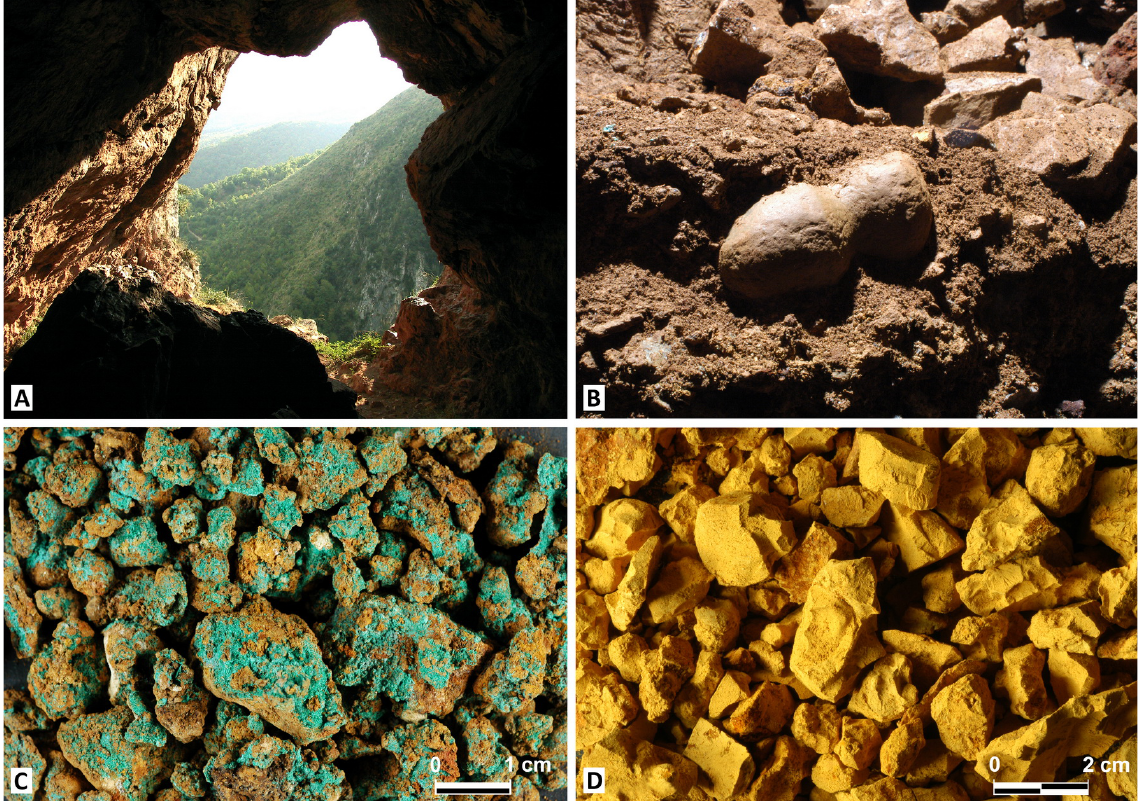
Figure 5. Grotta della Monaca (Sant'Agata di Esaro, Cosenza): A. entrance seen from the inside of the cavity; B. grooved hammer-axe half-buried in the sediment; C. lumps of malachite on fragments of limestone; D. crushed blocks of goethite (A: picture by D. Lorusso; B-D: pictures by F.